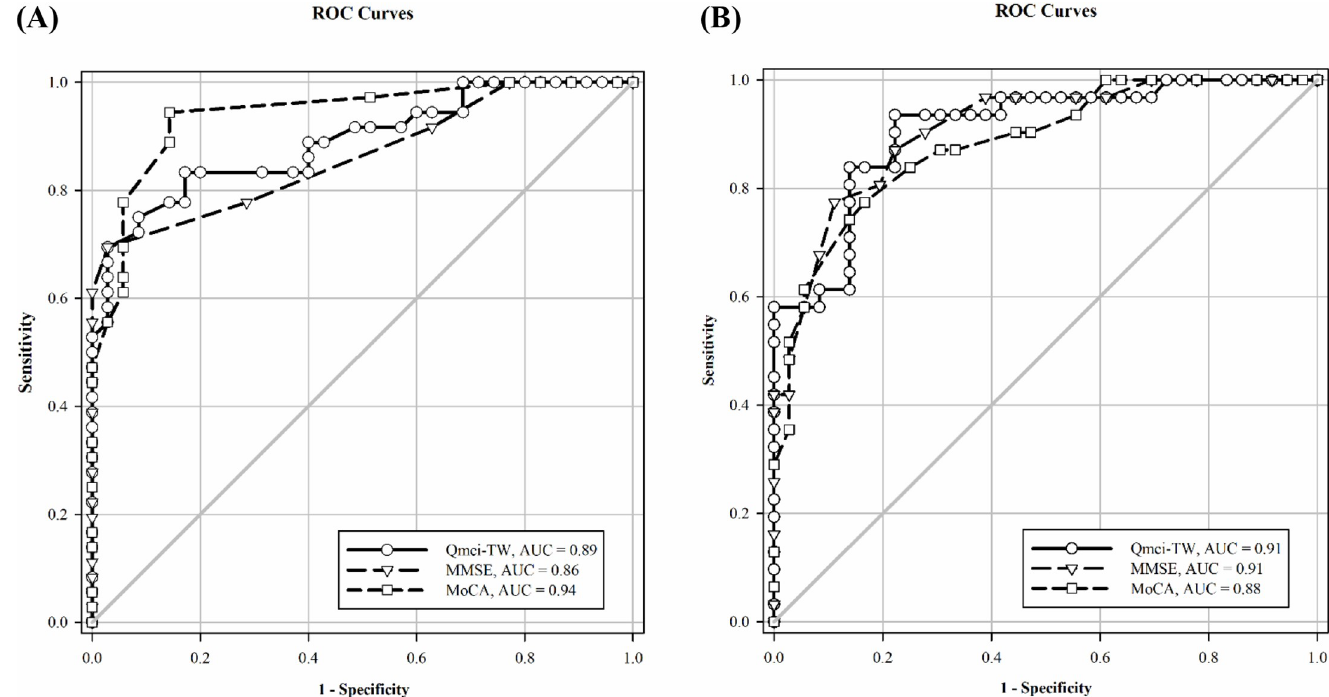
Fig 2. The ROC curves of the Q mci -TW, MoCA, and MMSE for differentiating (A) MCI from NC, and (B) dementia from